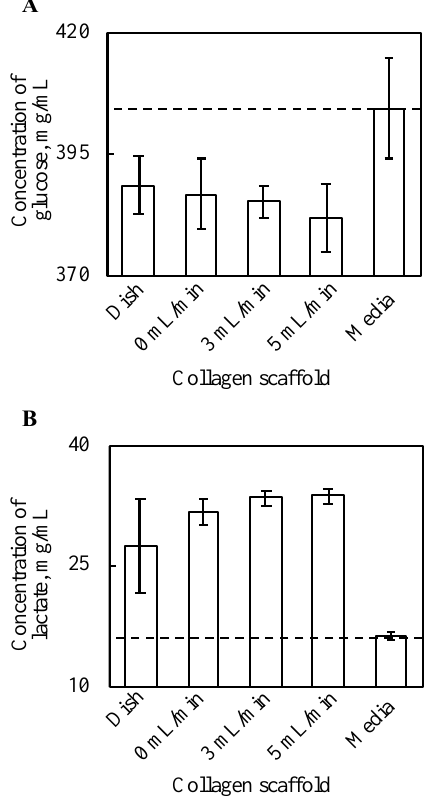
Figure 5. The results of glucose assay ( A ) and lactate assay ( B ) ( n = 3~7, mean ± SD). The y -axis represents the concentration of each substance in the supernatant with each culture method and incubated DMEM without cells. The cell tissue cultured on a collagen gel scaffold shows a higher glucose consumption and lactate production. Further, along with increasing perfusion speed, both the glucose consumption and lactate production increased.